Question: Based on the figure, does the quantity rise or fall?
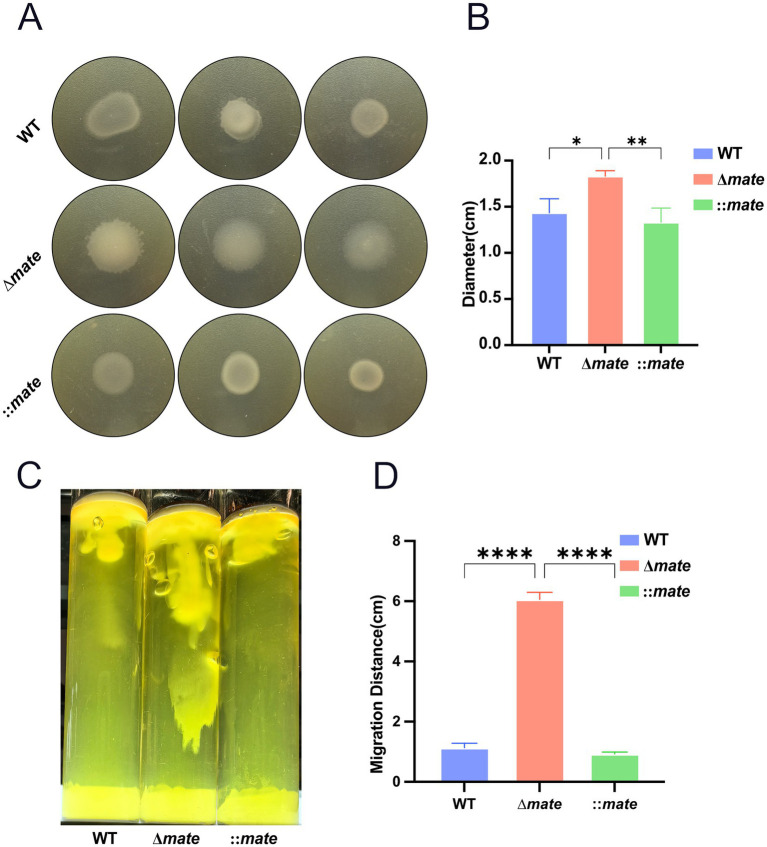
Answer: increasing